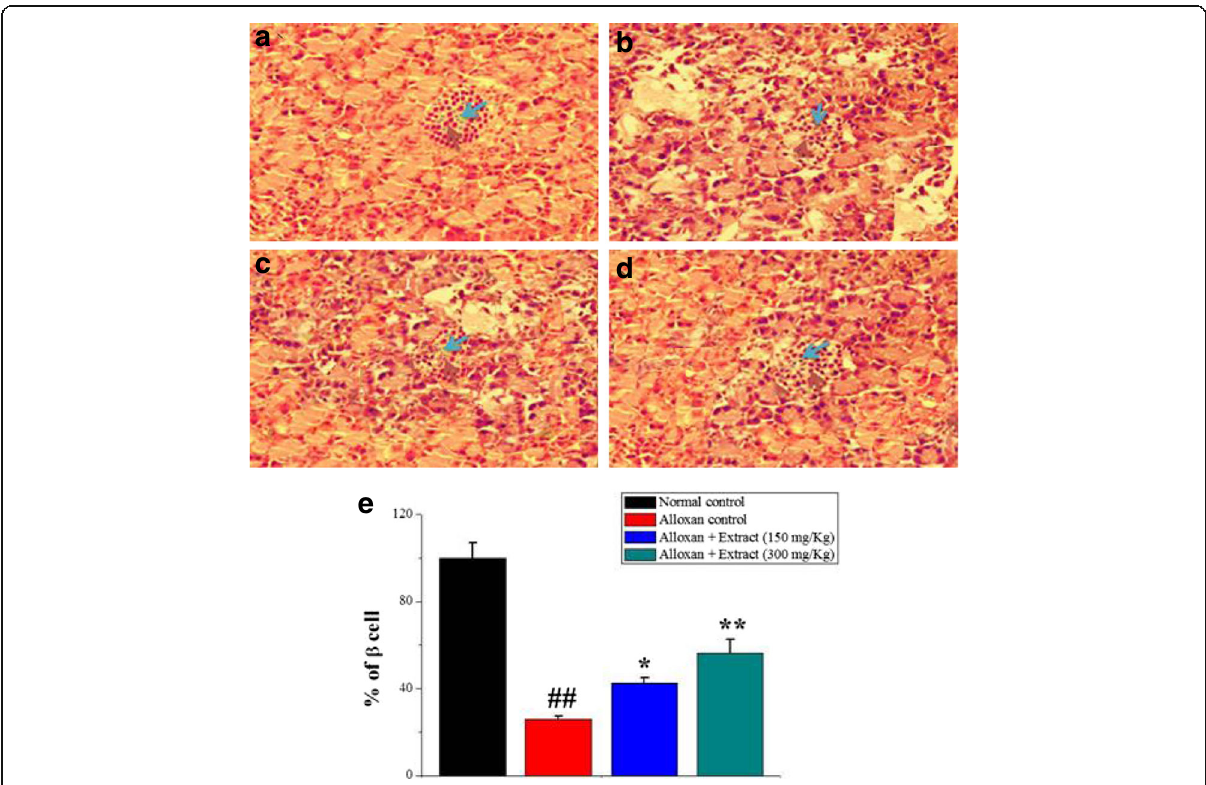
Fig. 9 Histopathological examination under microscopy: ( a ) Normal cellular population in the islets of langerhans in pancreas of vehicle-treated rats. b Extensive damage to the islets of langerhans and reduced dimensions of islets in diabetic control rats. ( c , d ) The partial restoration of normal cellular population and enlarged size of β -cells were shown by the extracts (150 mg/kg and 300 mg/kg), respectively. e The β -cell regeneration rate was determined by calculating the percentage of H & E positive cells over the total number of cells. Values were represented as mean ± SD. ## p < 0.01 as compared with the control group; *p < 0.05 and ** p < 0.01 as compared with the alloxan control group